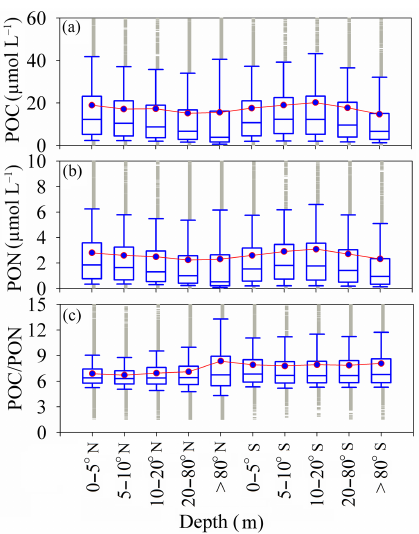
Figure 4. Depth dependence of POC and PON in the Southern Hemisphere and depth dependence of POC / PON in the Northern Hemisphere. The box plots show the median and 25th and 75th per- centiles, with whiskers covering most of the data. The red line with the green boxes shows the mean value at each